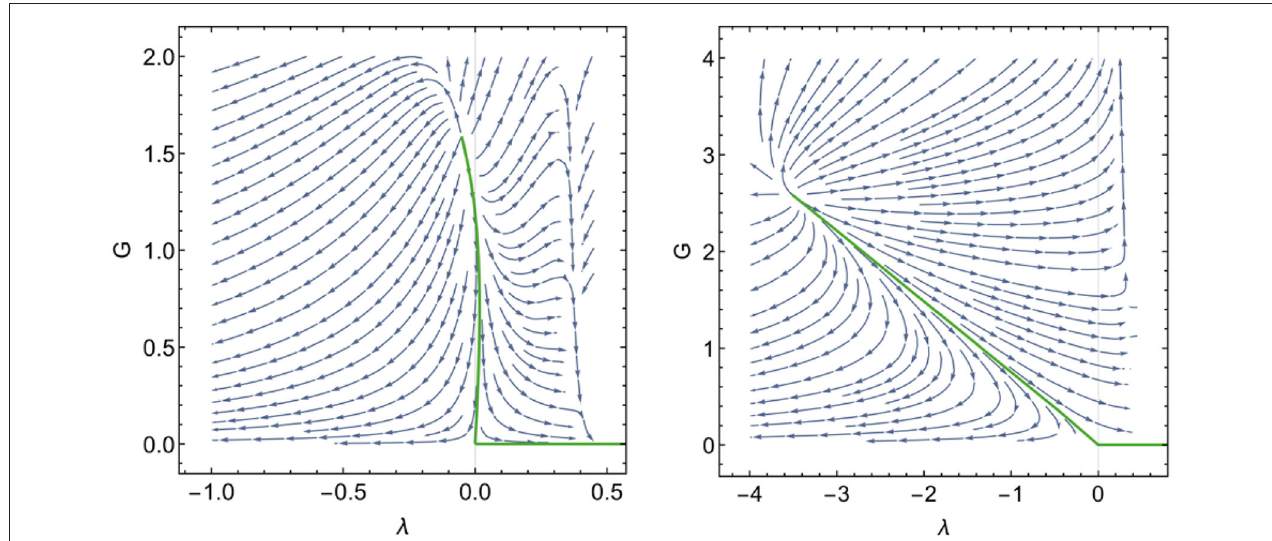
FIGURE 8 | The RG flow to the IR in the Einstein-Hilbert truncation in the setup discussed in Donà et al. (2014) for a type Ia cutoff features a trajectory—passing very close to the free fixed point—on which the dimensionful Newton coupling and cosmological constant reach constant values in the IR in agreement with measurements. Left panel: pure gravity case; right panel: including minimally coupled matter as in the Standard Model (4 scalars, 12 vectors, 45 Weyl fermions). The two eigendirections of the fixed point are superposition of G and λ .